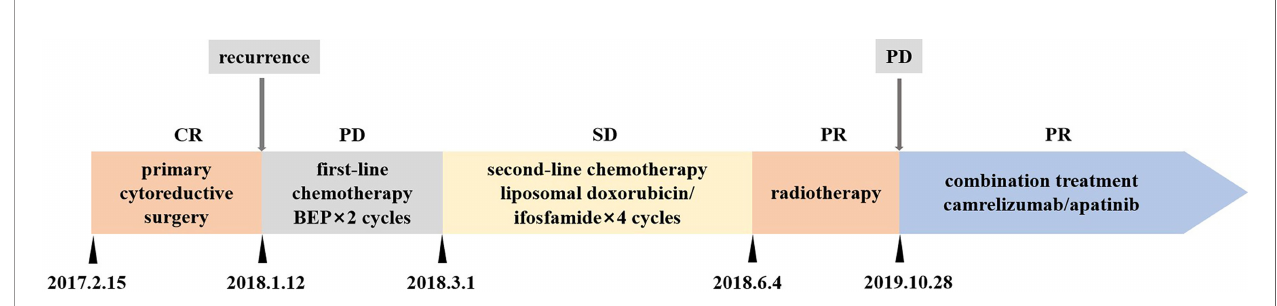
FIGURE 1 | Treatment timeline. CR, complete response; PR, partial response; SD stable disease; PD, progression disease; BEP, bleomycin, etoposide, and cisplatin.